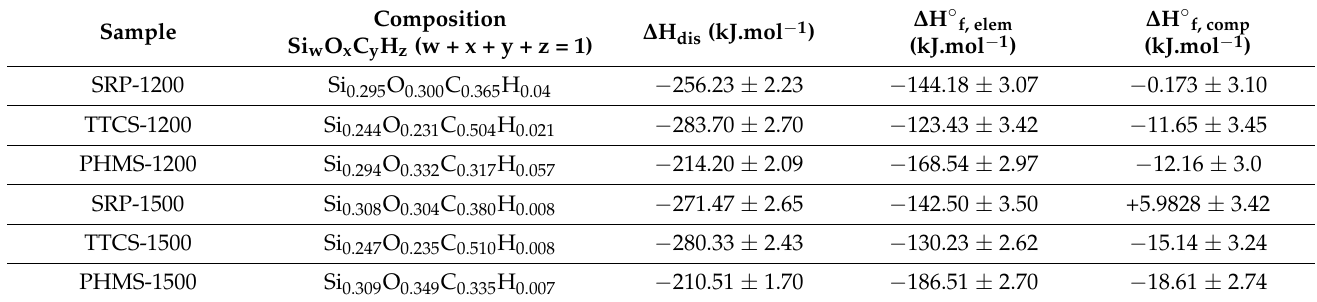
Table 4. Summary of enthalpies of formation from elements ∆ H ◦ f, elem and components ∆ H ◦ f, comp using composition from combustion analysis.